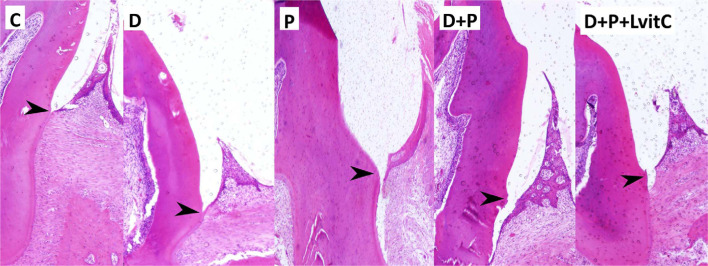
Photomicrographs of gingival mucosal tissues from all groups in the bucco-lingual sections of mandibular first molars (H&E staining). arrows; cement-enamel junction